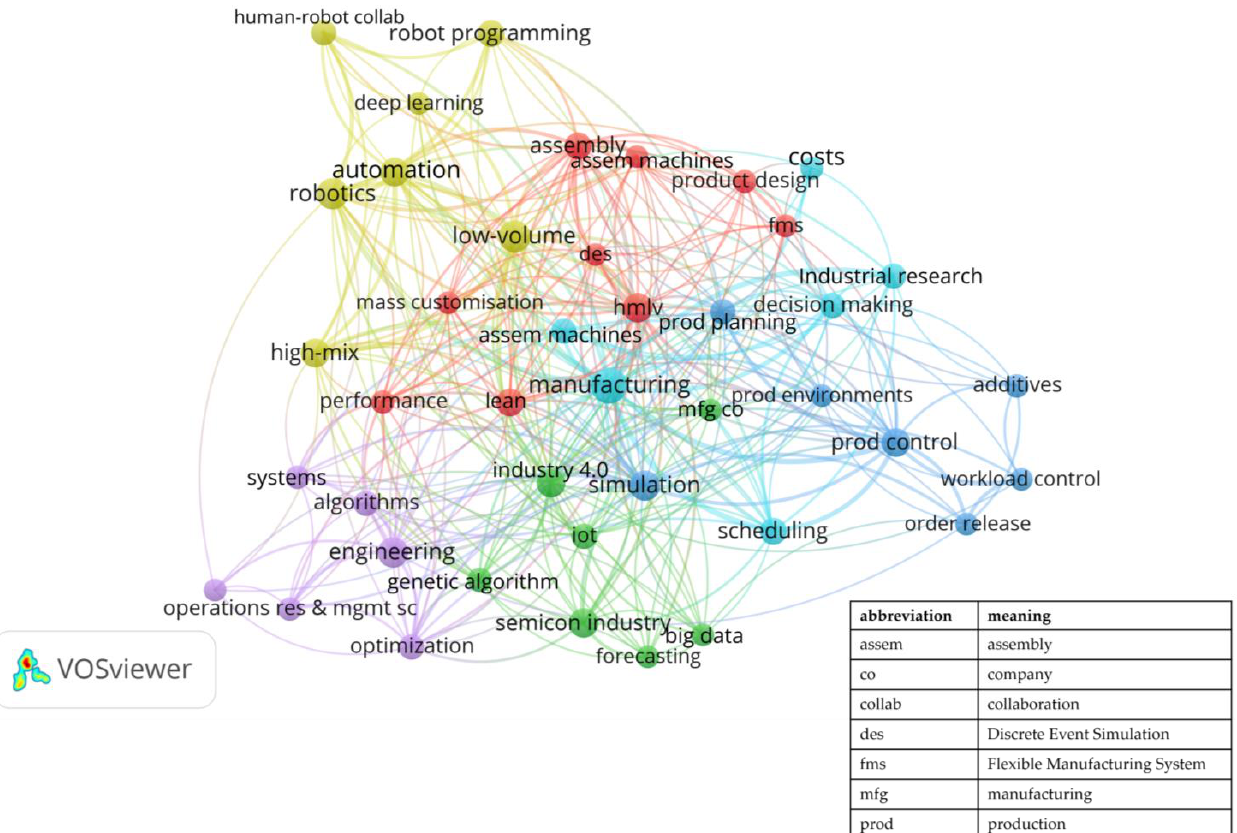
Figure 6. Publication keyword co-occurrence cluster during the 2017 – October 2022 phase .